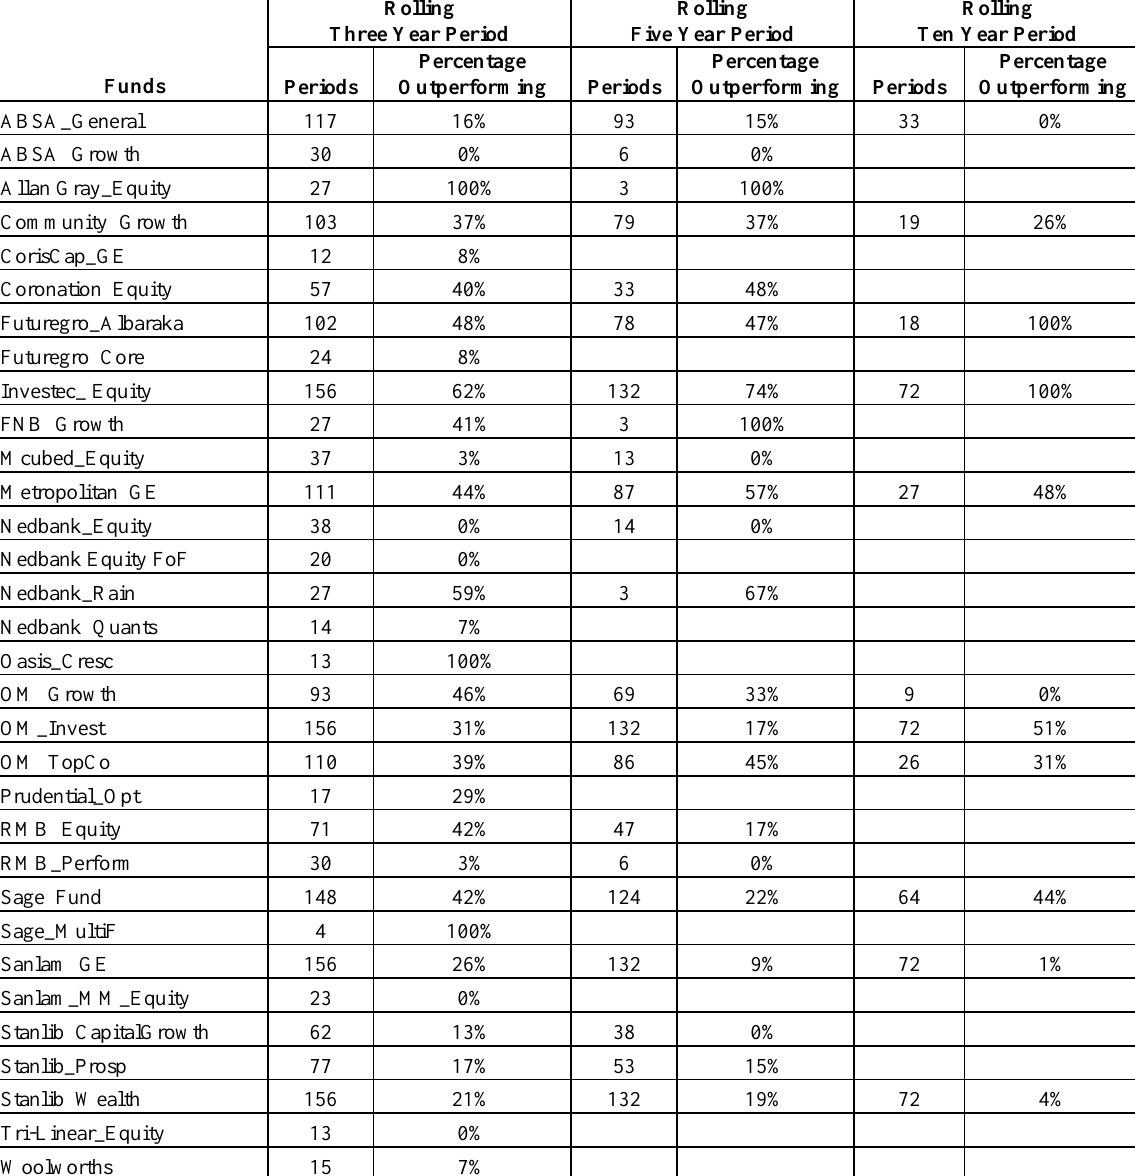
Table4: Consistency of Actively Managed Funds in Beating the ALSI Index